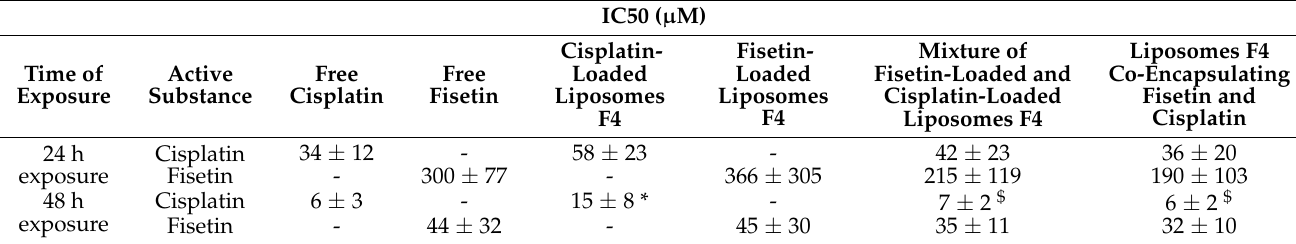
Table 4. IC50 values ( µ M) as function of cisplatin and fisetin on U-87 MG cell line (mean ± SD, n = 5). * p < 0.05 versus free drug. $ p < 0.05 versus liposomal drug encapsulated alone.